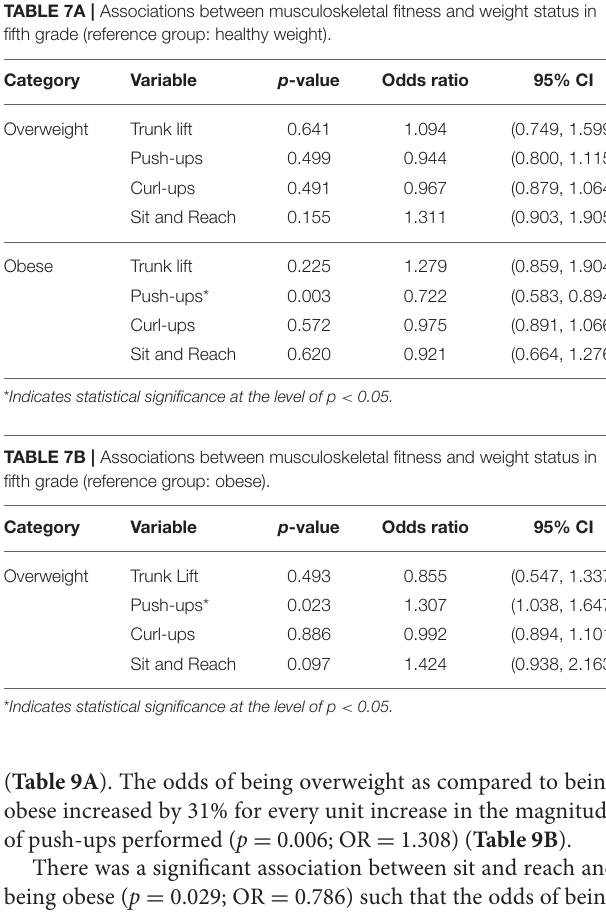
( Table 9A ). The odds of being overweight as compared to being obese increased by 31% for every unit increase in the magnitude of push-ups performed ( p = 0.006; OR = 1.308) ( Table 9B ). There was a significant association between sit and reach and being obese ( p = 0.029; OR = 0.786) such that the odds of